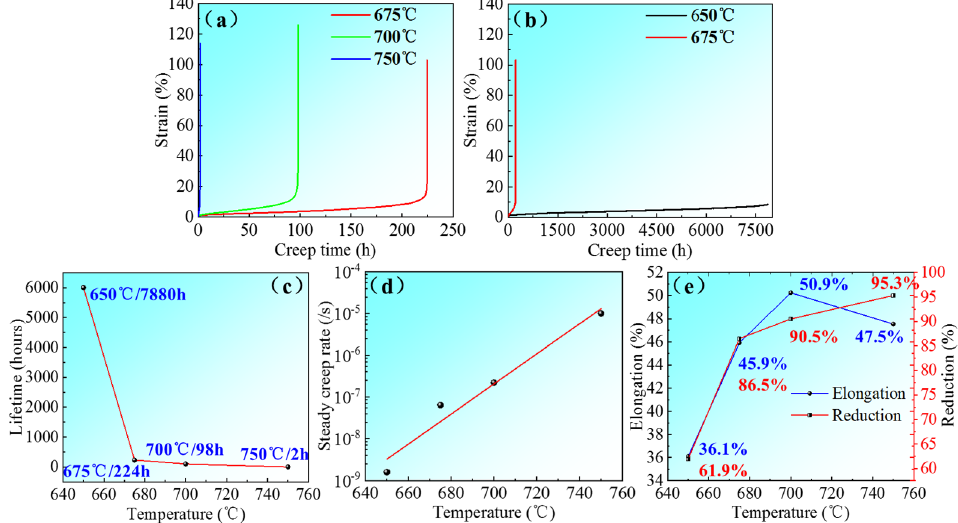
Figure 3. ( a , b ) Creep curves, ( c ) creep lifetime of T91 steel at different temperatures, ( d ) fitting analysis of the apparent activation energy of T91 steel, and ( e ) creep fracture plasticity at different temperatures.